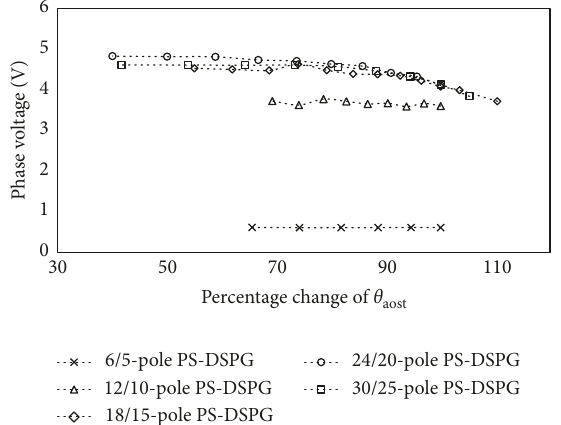
Figure 6: Open-circuit phase voltage of the proposed PS-DSPG structures with the percentage change of θ aost